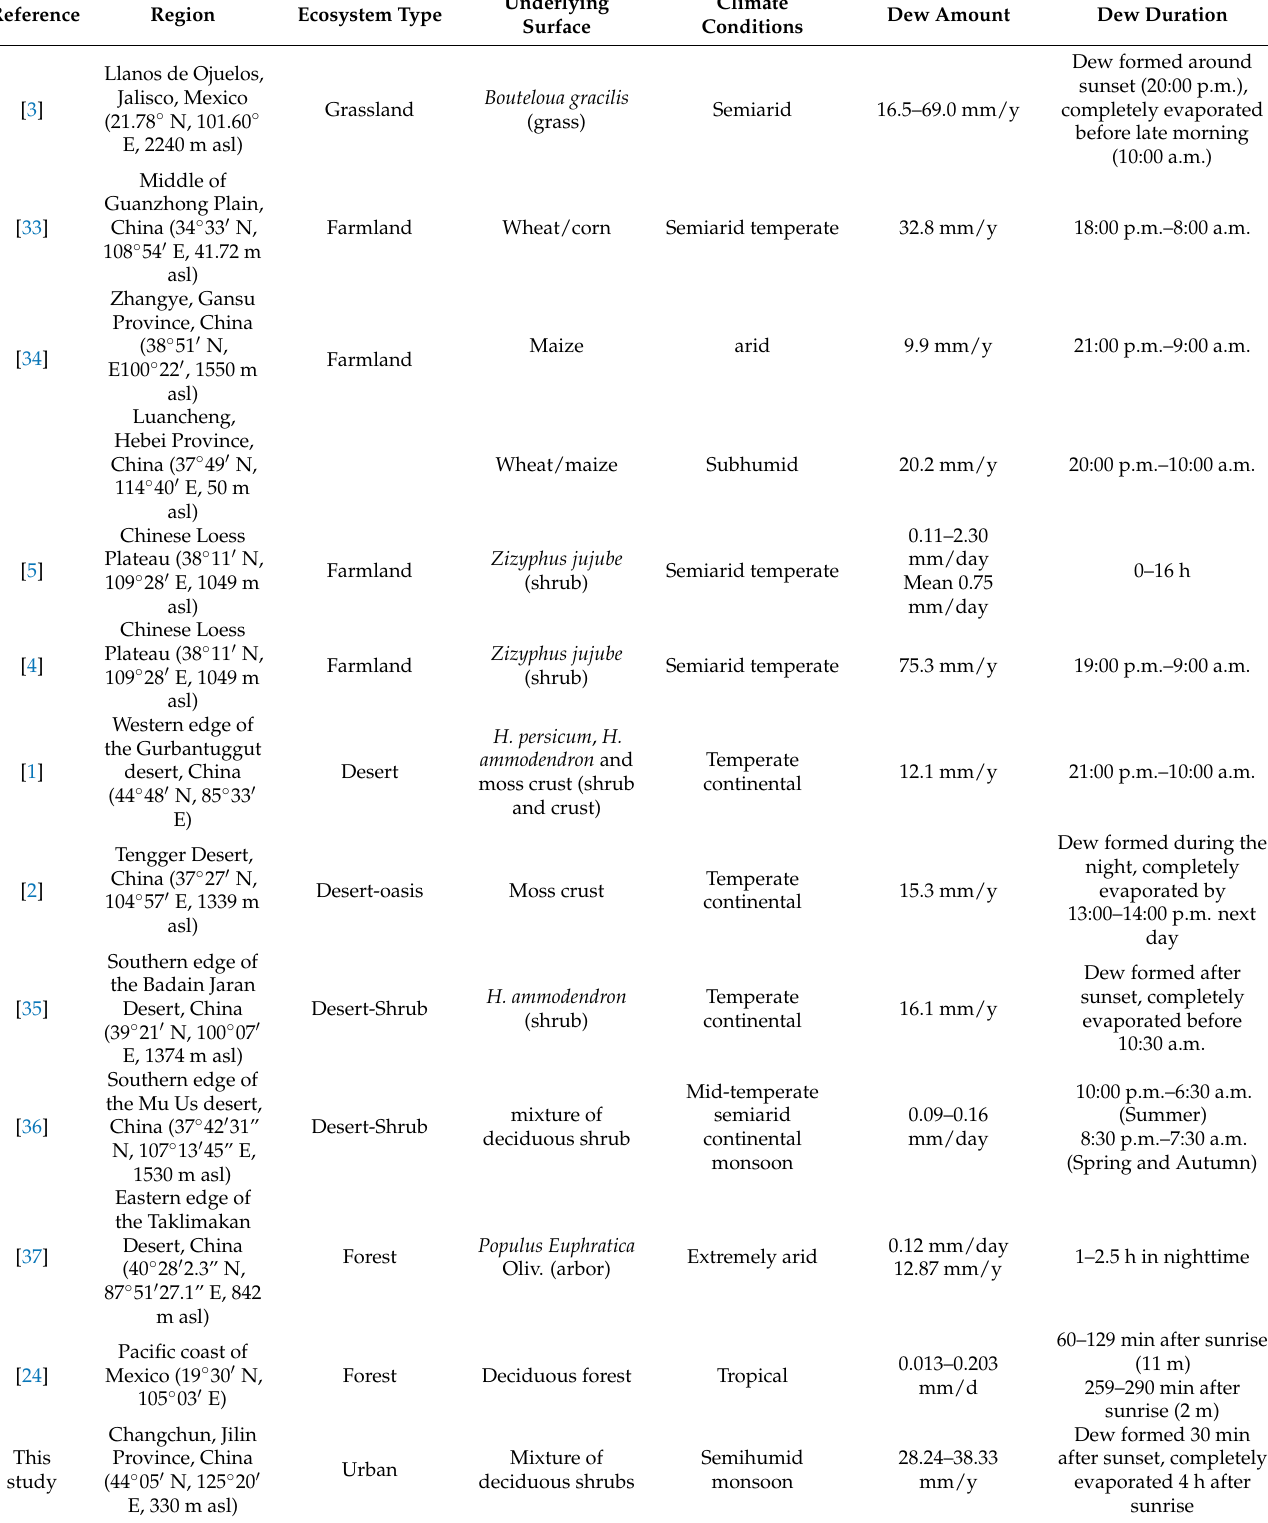
Table 1. Dew amounts and durations recorded in different